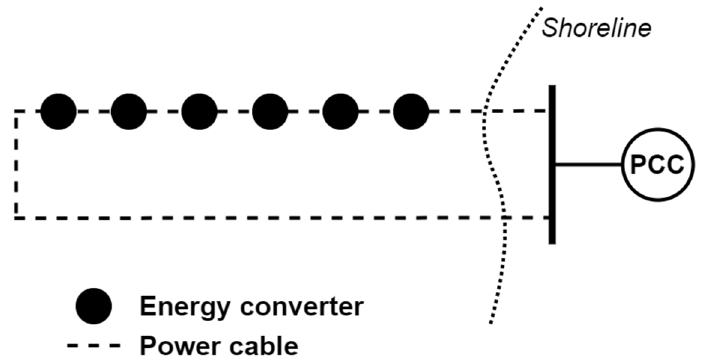
Figure 2. Single-sided ring topology.